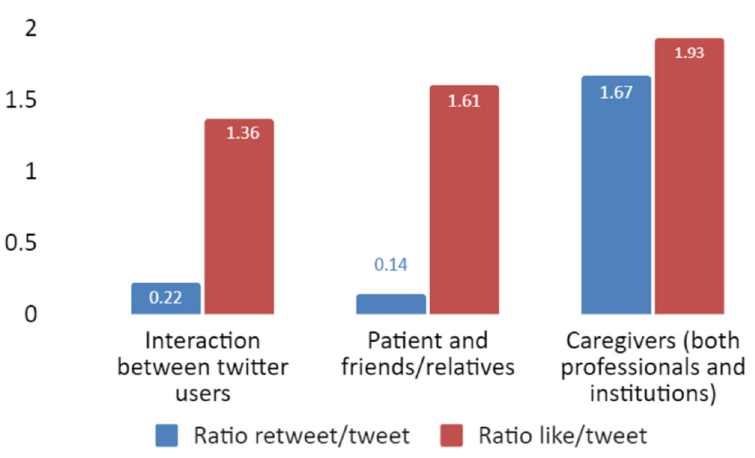
Figure 5. Retweet and like ratio ( Y -axis) by type of user ( X -axis).